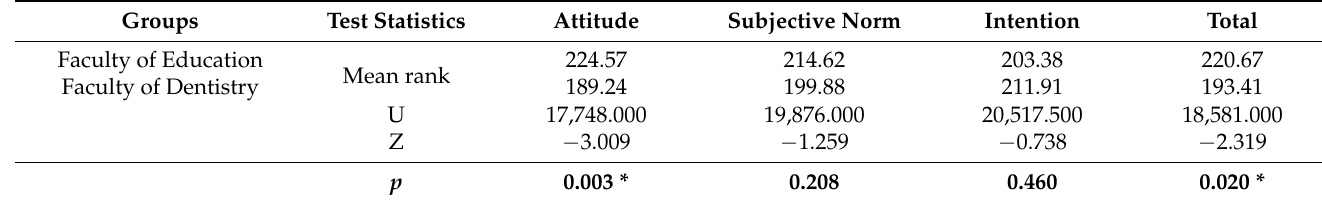
Table 4. Mann–Whitney U test results for the AUS scores according to